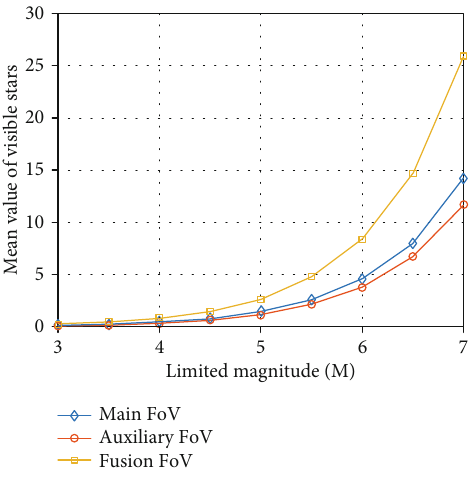
Figure 8: Mean value of visible stars for di ff erent FoVs.